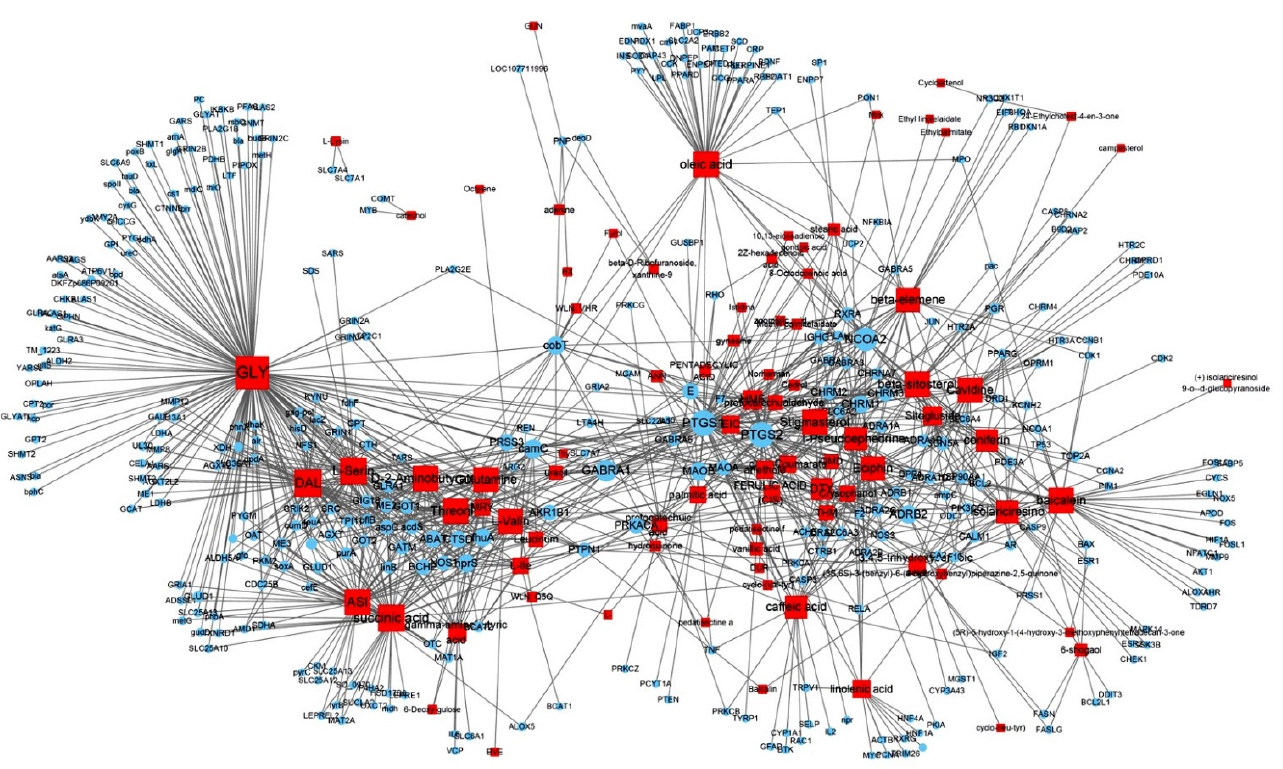
Figure 2. Compound–target network of Pinellia ternate Breitenbach . The size of the node depends on the number of connected edges. The compounds are expressed as red square nodes, and the targets are expressed as blue round nodes.